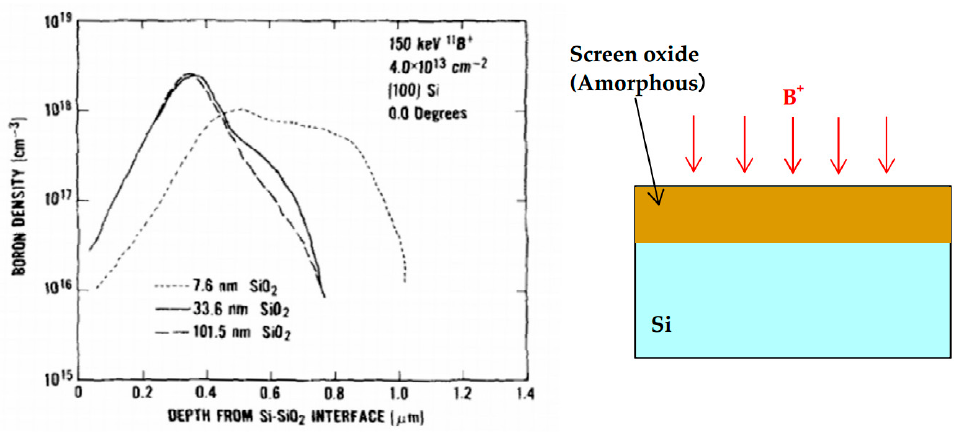
Figure 18. Boron density profile with various screen oxide thickness [30]. Wafer: (100) Silicon, Ion: 11 B + , Energy: 150 keV, Dose: 4 × 10 13 cm − 2 , Tilt: 0.0 ± 0.1°.